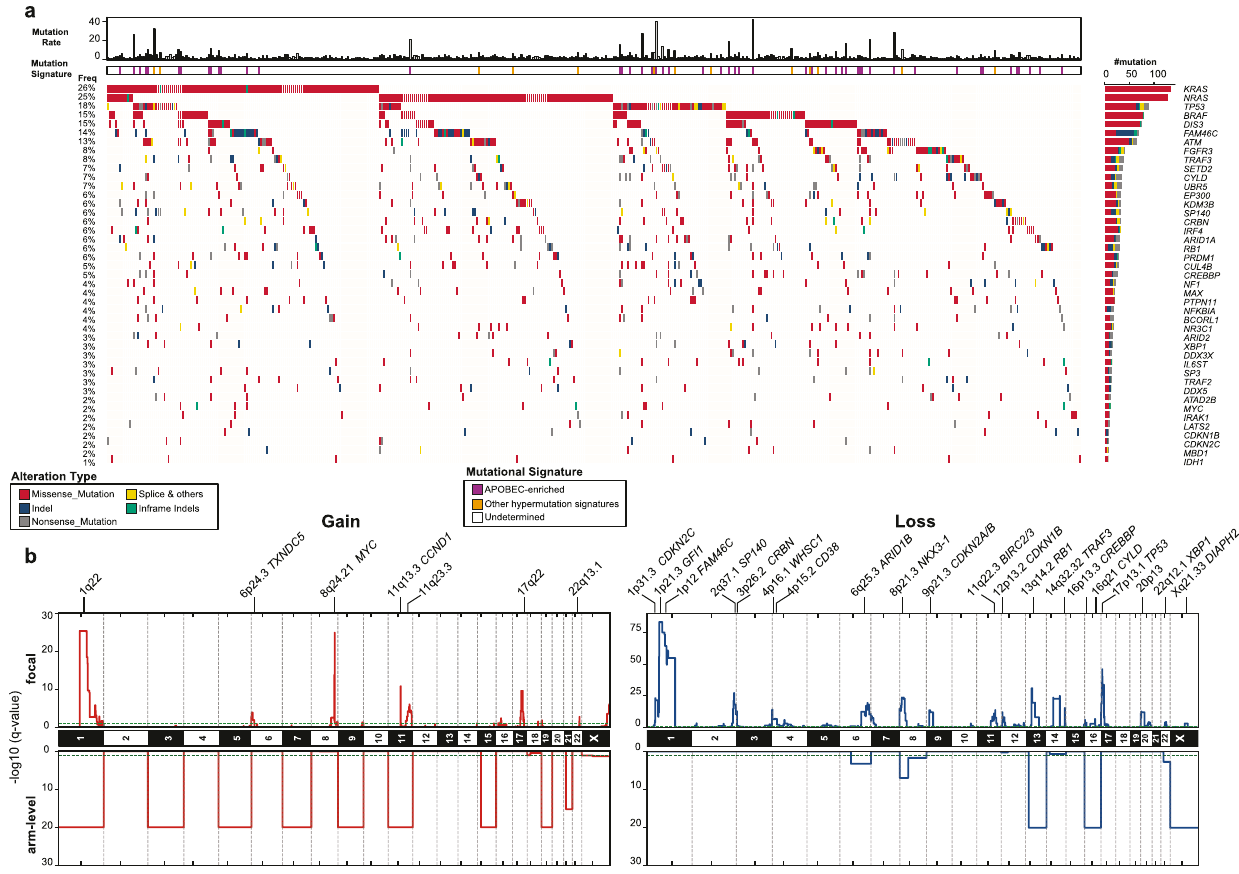
Fig. 1 The landscape of somatic alterations in relapsed refractory multiple myeloma. a Oncoprint of point mutations and small indels for signi fi cantly mutated genes in 511 cases of relapsed and refractory multiple myeloma (RRMM) from the MMRF Molecular Pro fi ling Initiative. The panel of signi fi cant genes was derived from an ensemble approach for statistical testing (Methods). Classes of alterations are indicated in the legend. The upper histogram represents the mutation rate (number of point mutations per megabase) per case. APOBEC and non-APOBEC hypermutated cases are indicated. The right histogram represents the number of patients with an indicated mutation in the cohort, with percentages provided on the left. b Consensus plot for arm- level (lower panel) and focal copy-number alterations (upper panel). Gains are shown in red and losses in blue. Relevant genes in the recurrent gain or loss regions are indicated. The q-values were calculated by GISTIC2.0. Horizontal dashed green lines correspond to q value =